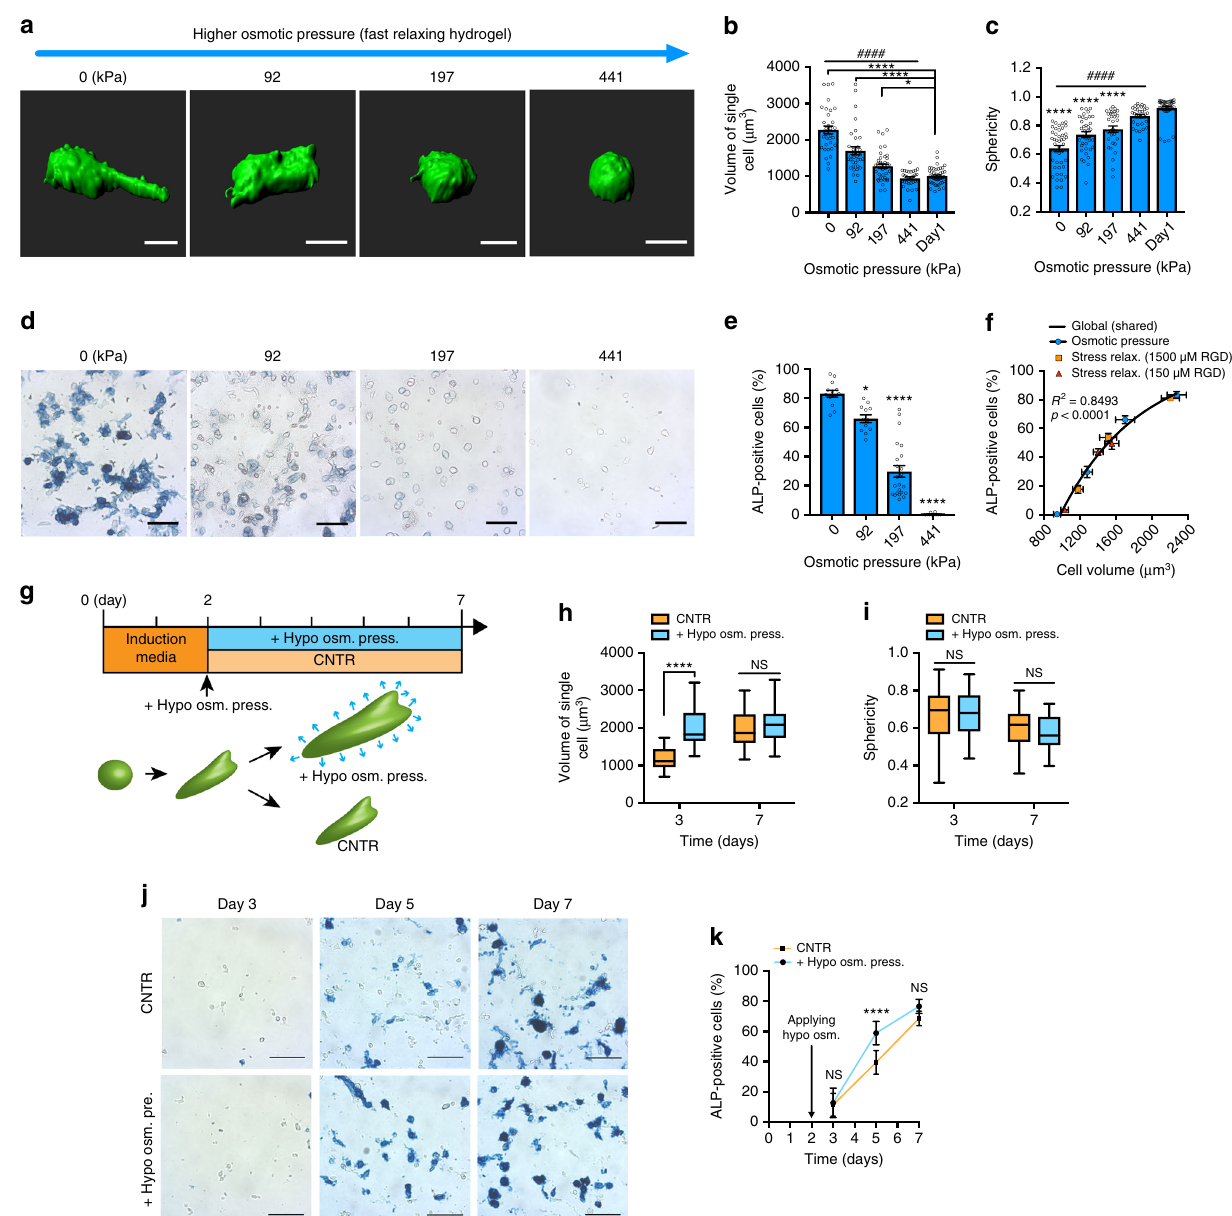
Fig. 2 Volume expansion regulates osteogenesis of MSCs in fast-relaxing hydrogels. a Representative 3D renderings of single MSCs from confocal imaging of a cell membrane dye within fast-relaxing hydrogels for 7 days under the indicated osmotic pressure. Scale bar, 10 µ m. b , c Quanti fi cation of cell volumes ( b ) and sphericity ( c ) of MSCs cultured in fast-relaxing gels with a RGD concentration of 1500 µ M under varied osmotic pressures for 7 days ( n ≥ 30 single cells from three biological replications per each condition). d Representative images of alkaline phosphatase staining for MSC cultured in fast-relaxing gels under indicated osmotic pressure for 7 days. Scale bar, 25 µ m. e Quanti fi cation of the percentage of cells positively stained for alkaline phosphatase produced by MSCs cultured for 7 days under indicated conditions ( n ≥ 10 images from three biological replications per each condition). f Scatter plot of cell volume with the percentage of cells positively stained for alkaline phosphatase produced by MSCs when volume of single cells was modulated by varying stress relaxation, RGD density, or osmotic pressure. A non-linear regression analysis showed a global trend of osteogenic differentiation with volume of single cells. g Schematic of protocol for application of hypoosmotic pressure to enhance volume expansion. h , i Quanti fi cation of cell volume ( h ) and sphericity ( i ) for MSCs cultured under hypoosmotic pressure or control conditions at days 3 and 7 ( n ≥ 30 single cells from three replications per each condition). The box plots show 25/50/75th percentiles and whiskers show minimum/maximum. j Representative images of ALP staining of MSCs cultured in hypoosmotic media or control media at days 3, 5, and 7 ( n ≥ 10 images from three replications per each condition). k Quanti fi cation of ALP-positive cells for MSCs in hypoosmotic or control medium at days 3, 5, and 7. ( n ≥ 8 images from three replications per each condition). All data are shown as mean ± s. e.m. For one-way ANOVA comparisons; * p <0.05, ** p <0.01, *** p <0.001, and **** p <0.0001 and for Spearman ’ s rank correlation; #### p